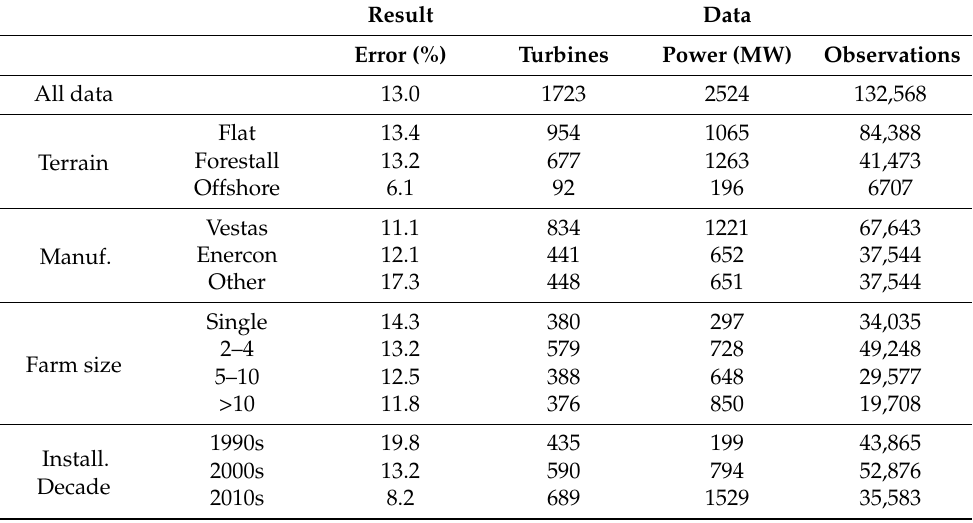
Table 2. Error of AEP predictions compared to the production-based WCP for the full data set of the study and divided into terrain type, manufacturer, wind farm size, and decade of